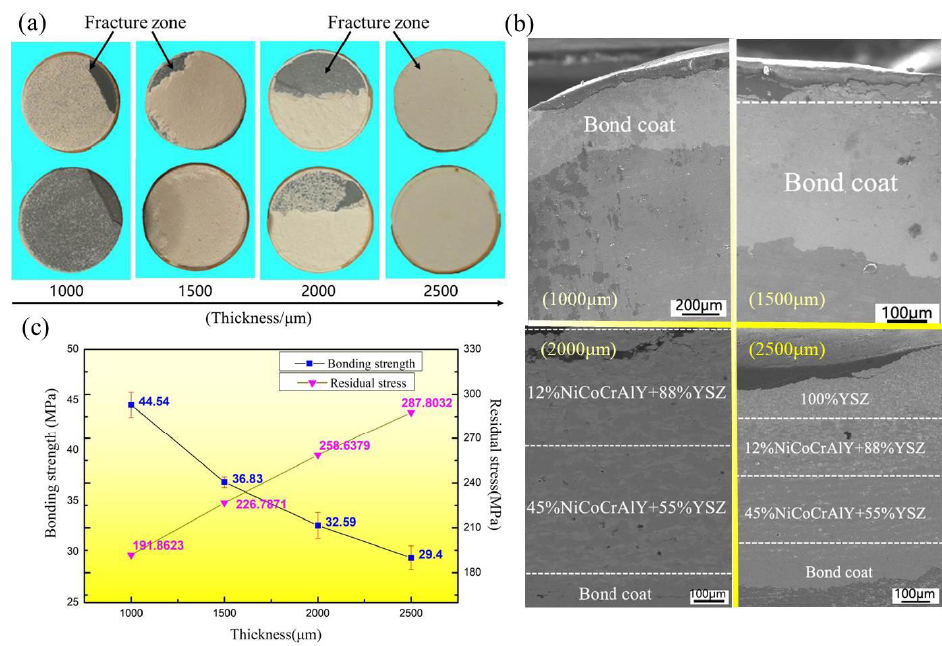
Figure 5. ( a ) Fracture morphology of samples after uniaxial tensile test; ( b ) SEM images of polished cross-section in ( a ); ( c ) Bonding strength and residual stress for the coatings with various thicknesses.